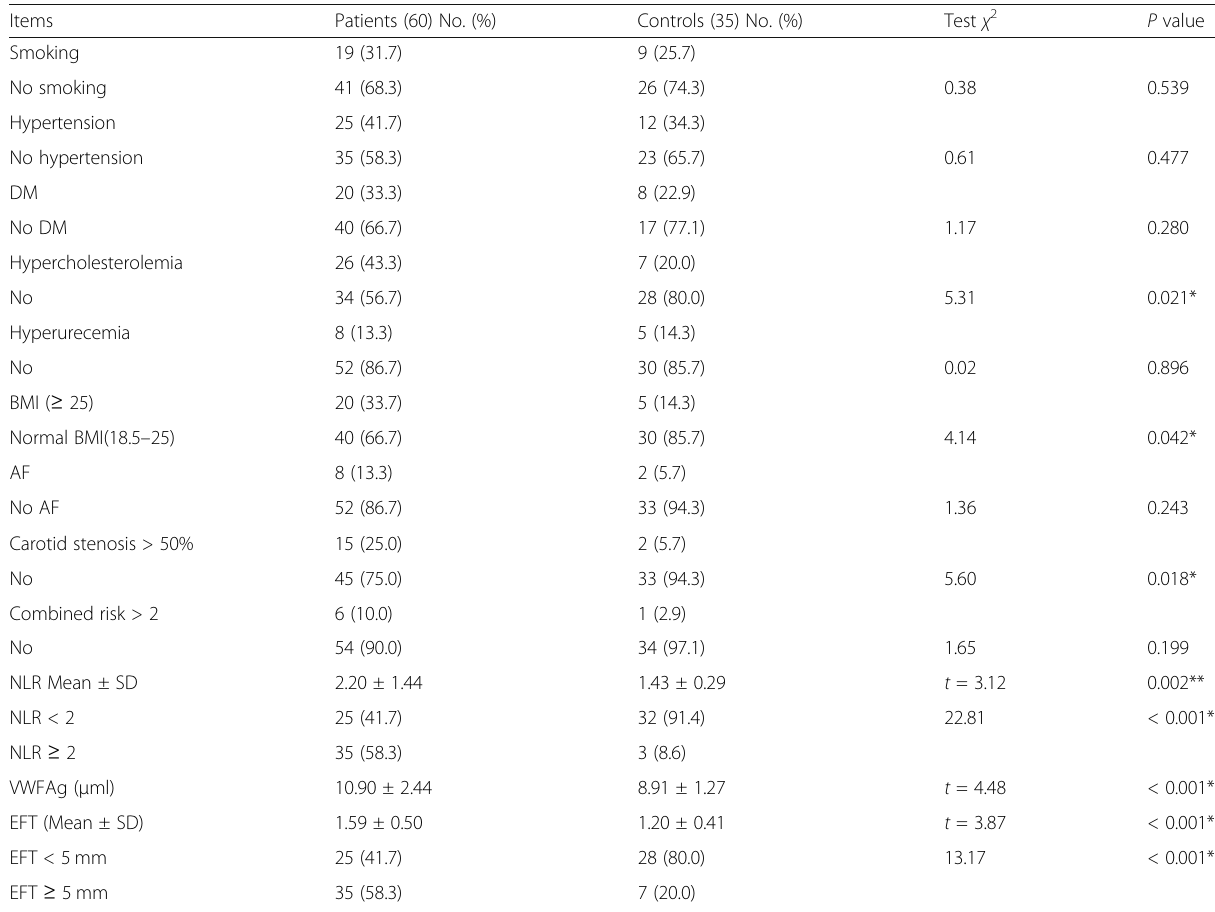
Table 1 Risk factors, EFT, NLR, and VWF among acute ischemic stroke patients and